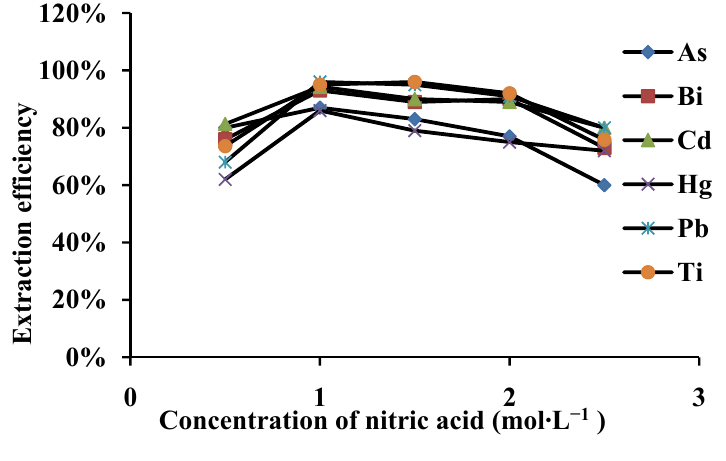
Figure 3. Effect of nitric acid at various concentrations as eluent on extraction efficiency of the metal ions (N = 3).